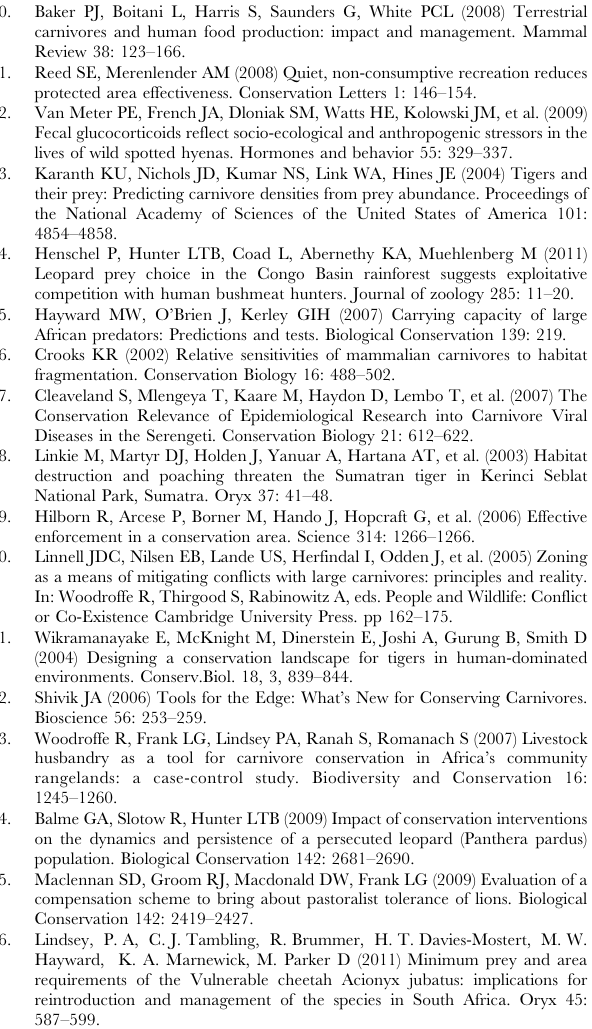
Table S2 Variance inflation factors and correlation coefficients for covariates used in models of carnivore occurrence and detection probability. Appendix S1 Further detail on the assessment of spatial autocorrelation in carnivore occurrence patterns.